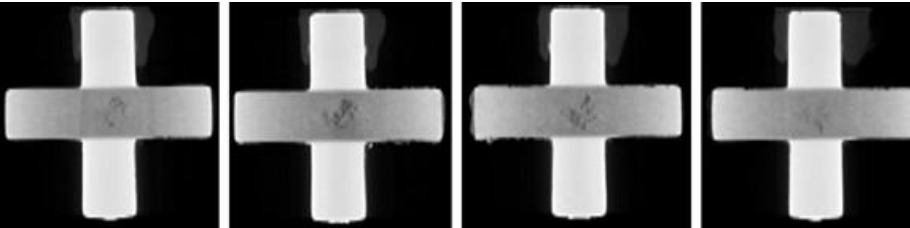
Figure 4. Example of tomography sections for a cross-shaped casting inoculated with Ce-inoculant; volume of internal defect: 101.82 mm 3 .